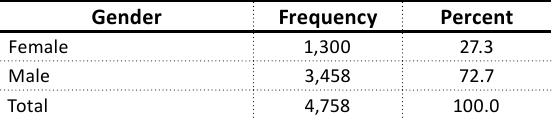
Table 3. Gender distribution of households